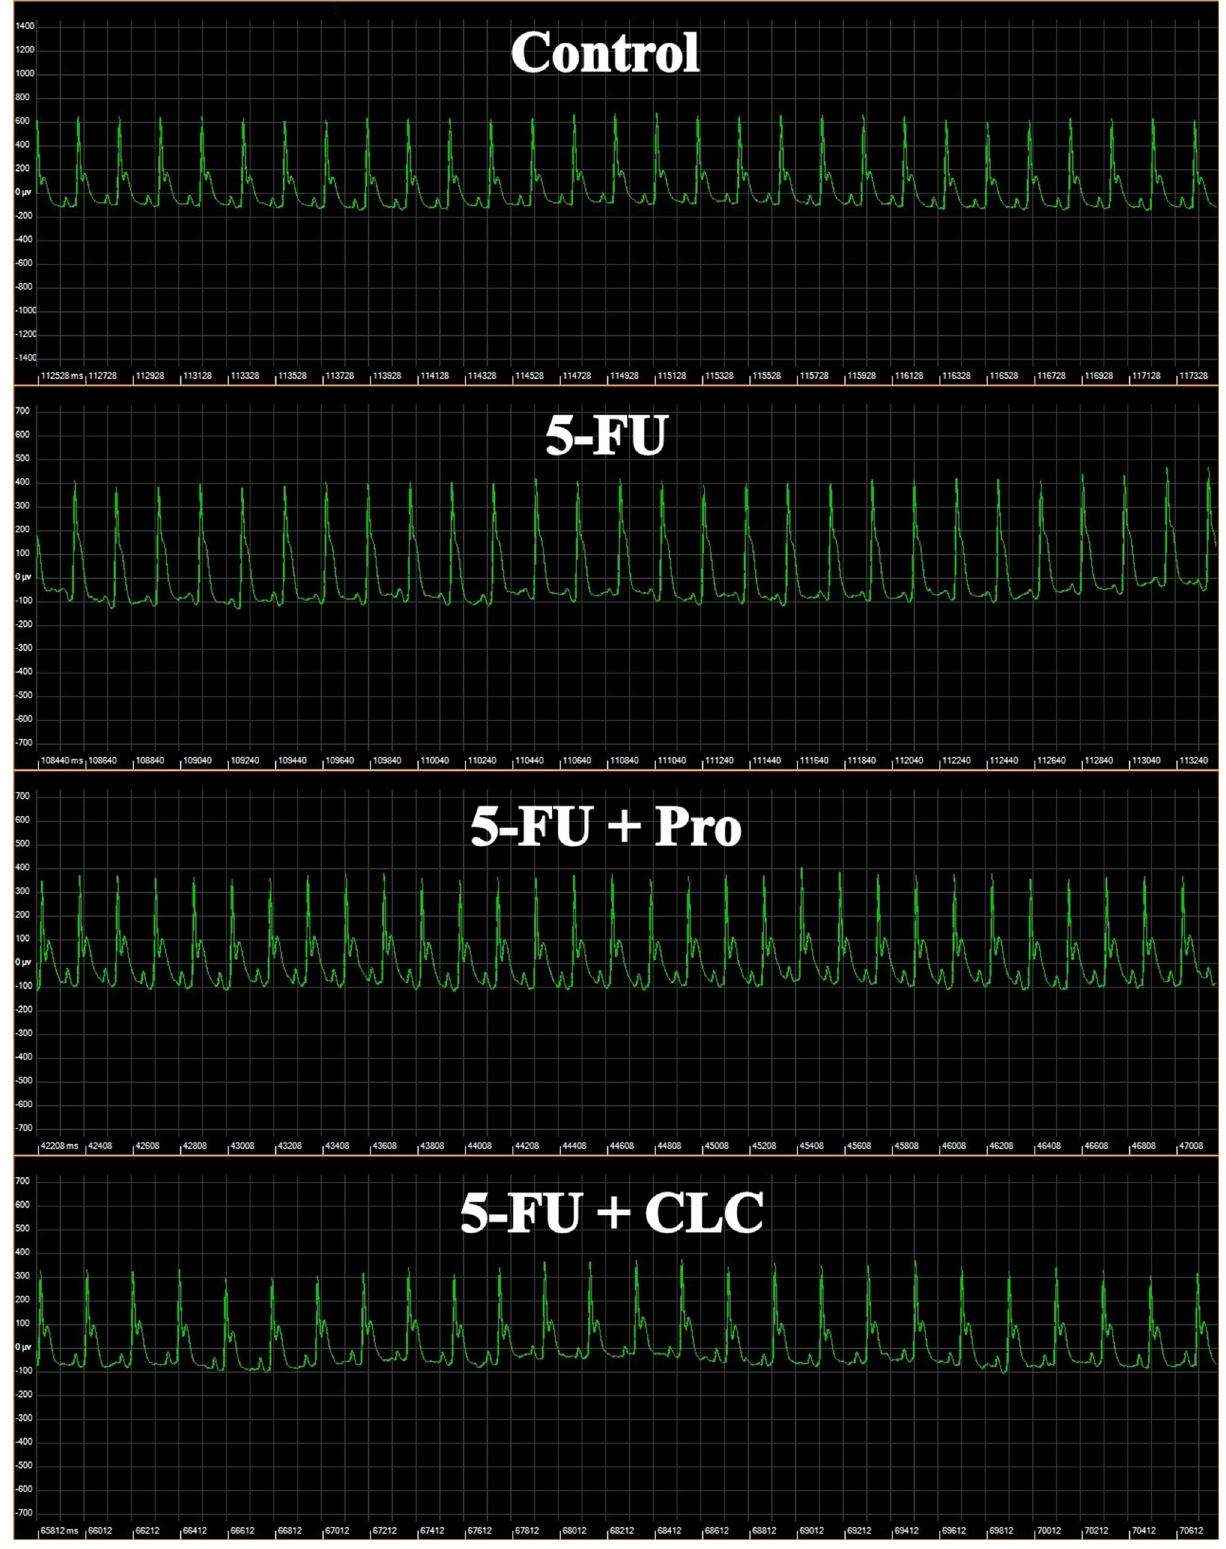
Figure 4. ECG images of study rats. Groups: Control, Normal saline; 5-FU, 5-FU 125 mg/kg; 5-FU + Pro, 5-FU 125 mg/kg + Propolis ethanolic extract 250 mg/kg/d; 5-FU + CLC, 5-FU 125 mg/kg + Colchicine 5